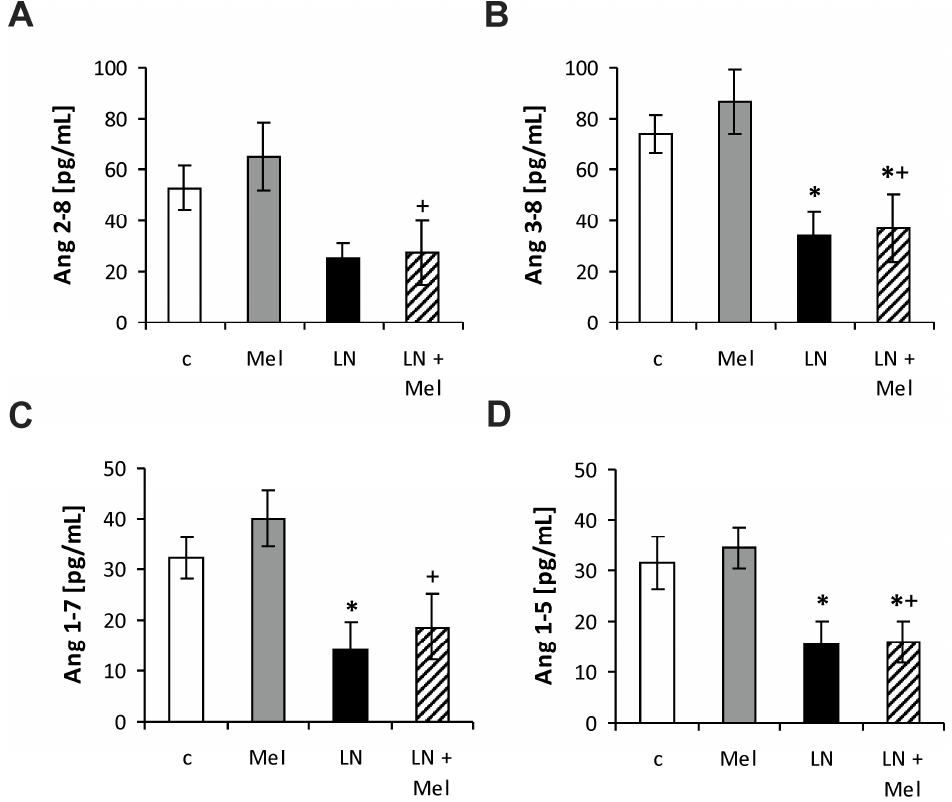
Figure 5. The influence of melatonin (LN + Mel) on the serum level of angiotensin 2–8 (Ang 2–8) ( A ); angiotensin 3–8 (Ang 3–8) ( B ); angiotensin 1–7 (Ang 1–7) ( C ); angiotensin 1–5 (Ang 1–5) ( D ). Wistar controls (c); L -NAME (LN); melatonin (Mel); n = 6 per group; * p < 0.05 vs. c; + p < 0.05 vs. Mel.